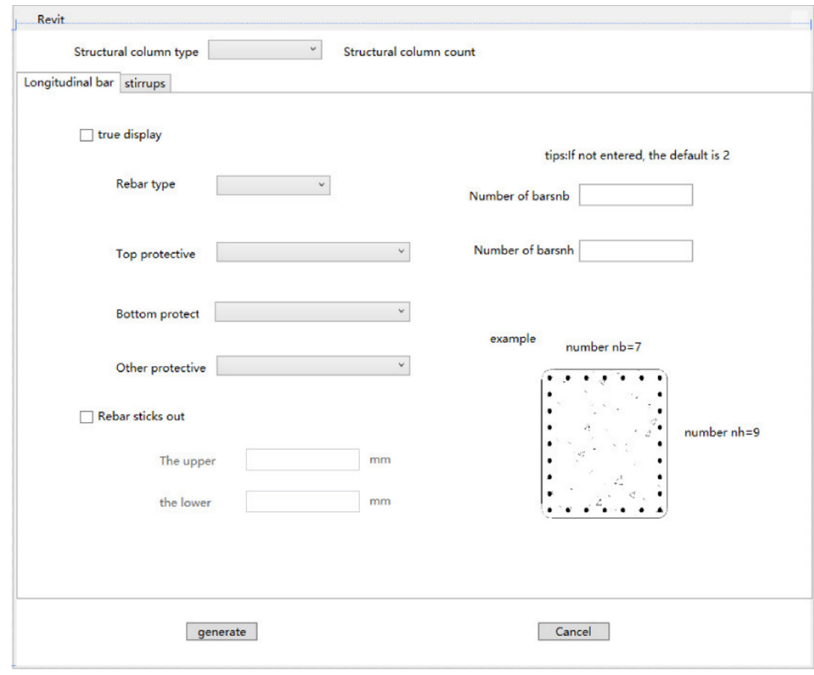
Figure 2. WPF interactive interface.